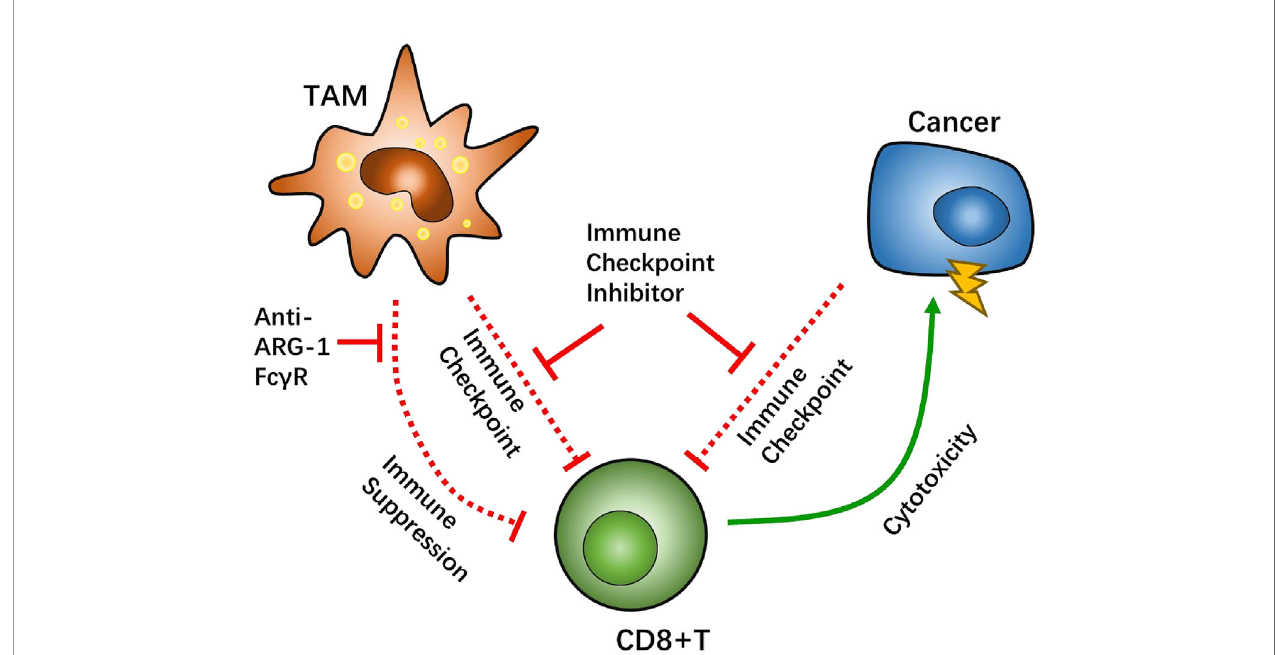
FIGURE 4 | Tumor-associated macrophages (TAMs) factor as potential targets to overcome CD8-positive (CD8+) T cells suppression. The Fc g receptor (Fc g R) has been tested in vivo as a target for TAMs-CD8+ T cell interaction. Arginase-1 (ARG-1) can regulate CD8+ T cell metabolism via L-arginine